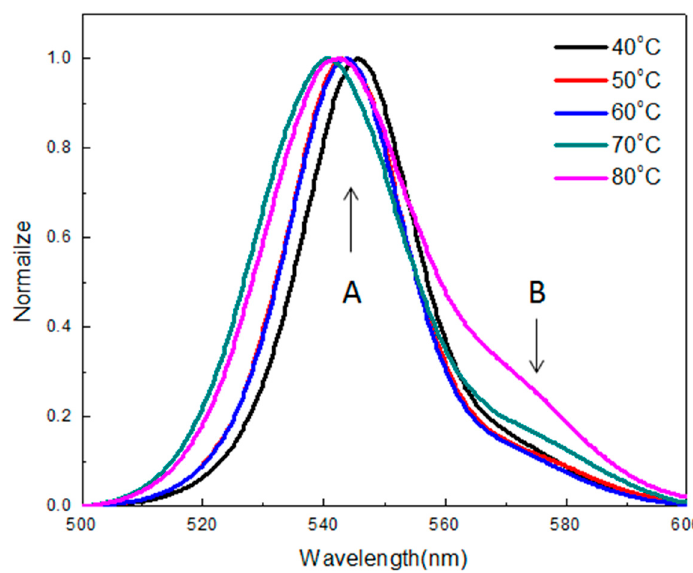
Figure 4. Photoluminescence (PL) spectra of the MAPbBr 3 crystals prepared at various temperatures.